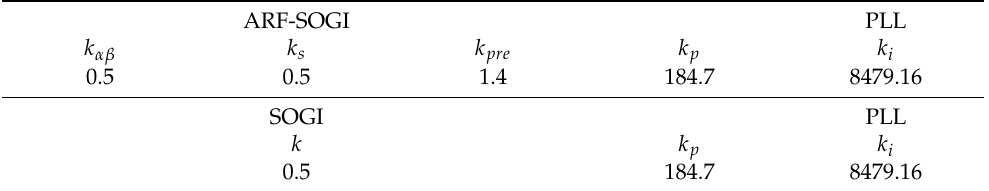
Table 1. Gains for tuning set S1 (small SOGI bandwidth, typical PLL